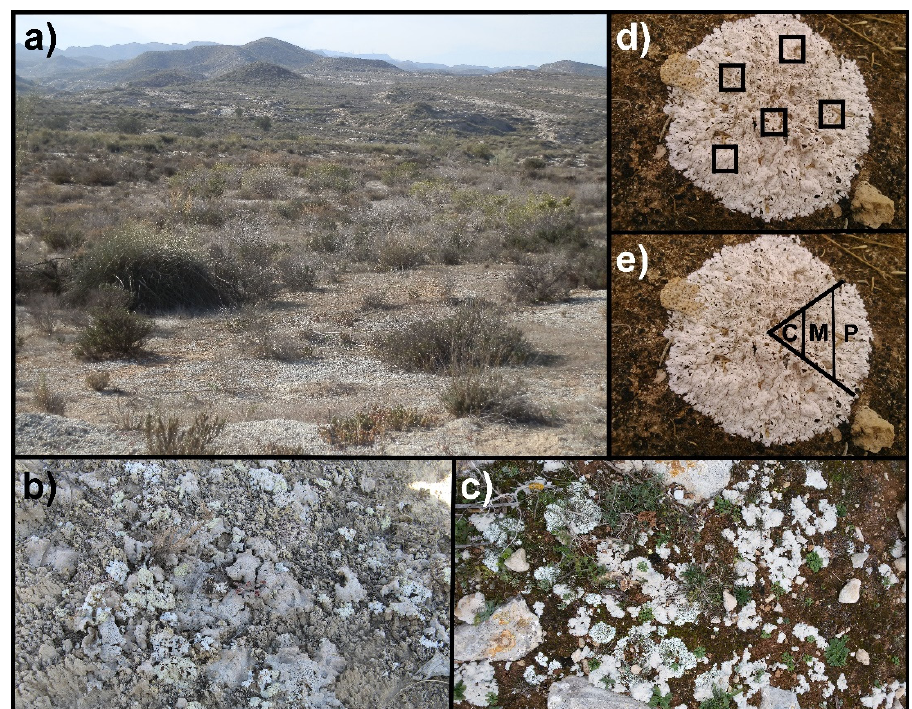
Figure 1. ( a ) Soil crust community on Miocene gypsum soil in a Mediterranean shrub community in Almería, Spain. ( b ) Detail of the biocrust community in Titulcia, Madrid, Spain where Diploschistes diacapsis is the prevailing lichen. ( c ) Detail of biocrust community on calcareous soil in Mallorca, Spain. Preparation of lichen material prior to DNA extraction performed in this study, ( d ) several parts of this thallus were randomly selected and mixed (MIX) and ( e ) selected thallus was also further divided into three parts: central (C, corresponding to the most inner part), middle (M, midpoint part) and periphery (P, most external part of the thallus). Specimen from Mallorca (Balearic Islands). Photo: Arantzazu Molins.